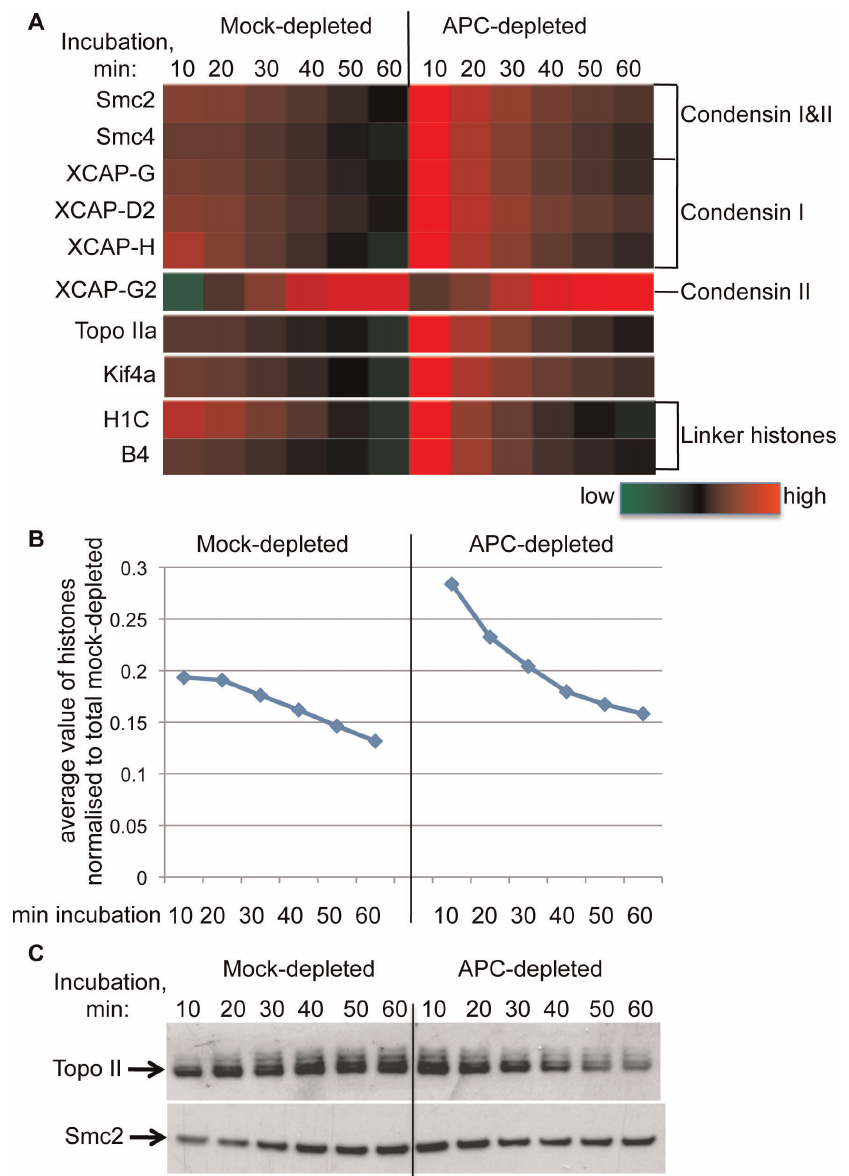
Figure 5. Effect of APC depletion on known mediators of chromatin compaction. A . Dynamics of chromatin association of indicated components of condensin I and II complexes, Topoisomerase IIa, Kif4 and two linker histones in mock-and APC-depleted extract, as determined in the proteomic screen is represented in a heat map, color-coded as in fig. 4. B . Average values from all histones identified in the screen (H2B, H2A, H2A.ZI2, H1C, hist1H4I and B4) normalized to corresponding total signal in mock-depleted samples. C . Immunoblotting of the chromatin samples prepared as for the proteomic screen, with antibodies recognizing Xenopus TopoII (top panel) and Smc2 (bottom panel). Each lane contains the equivalent of 200 ng chromatin.